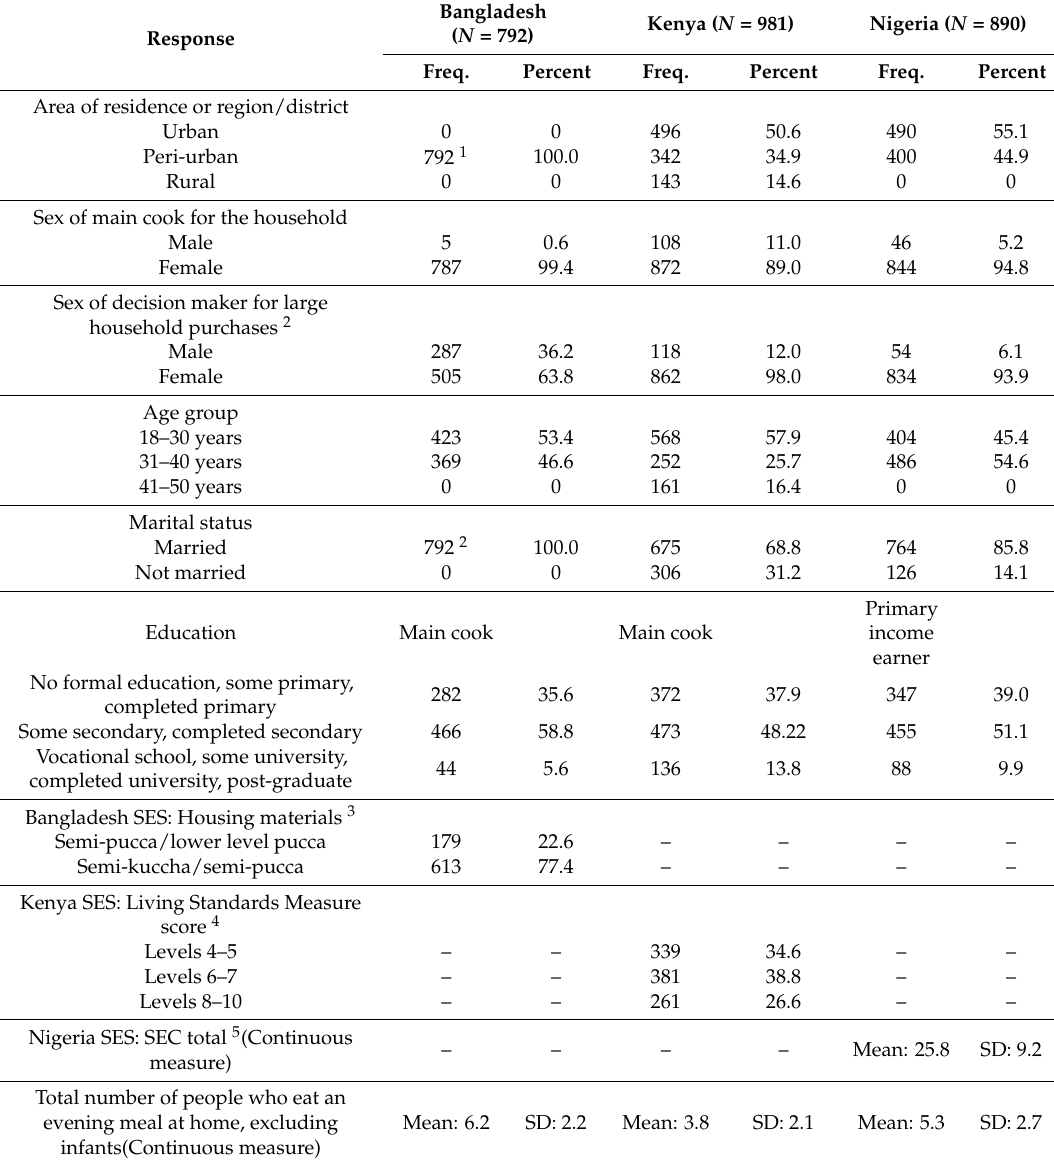
Table 3. Sample descriptive characteristics. (Freq. denotes